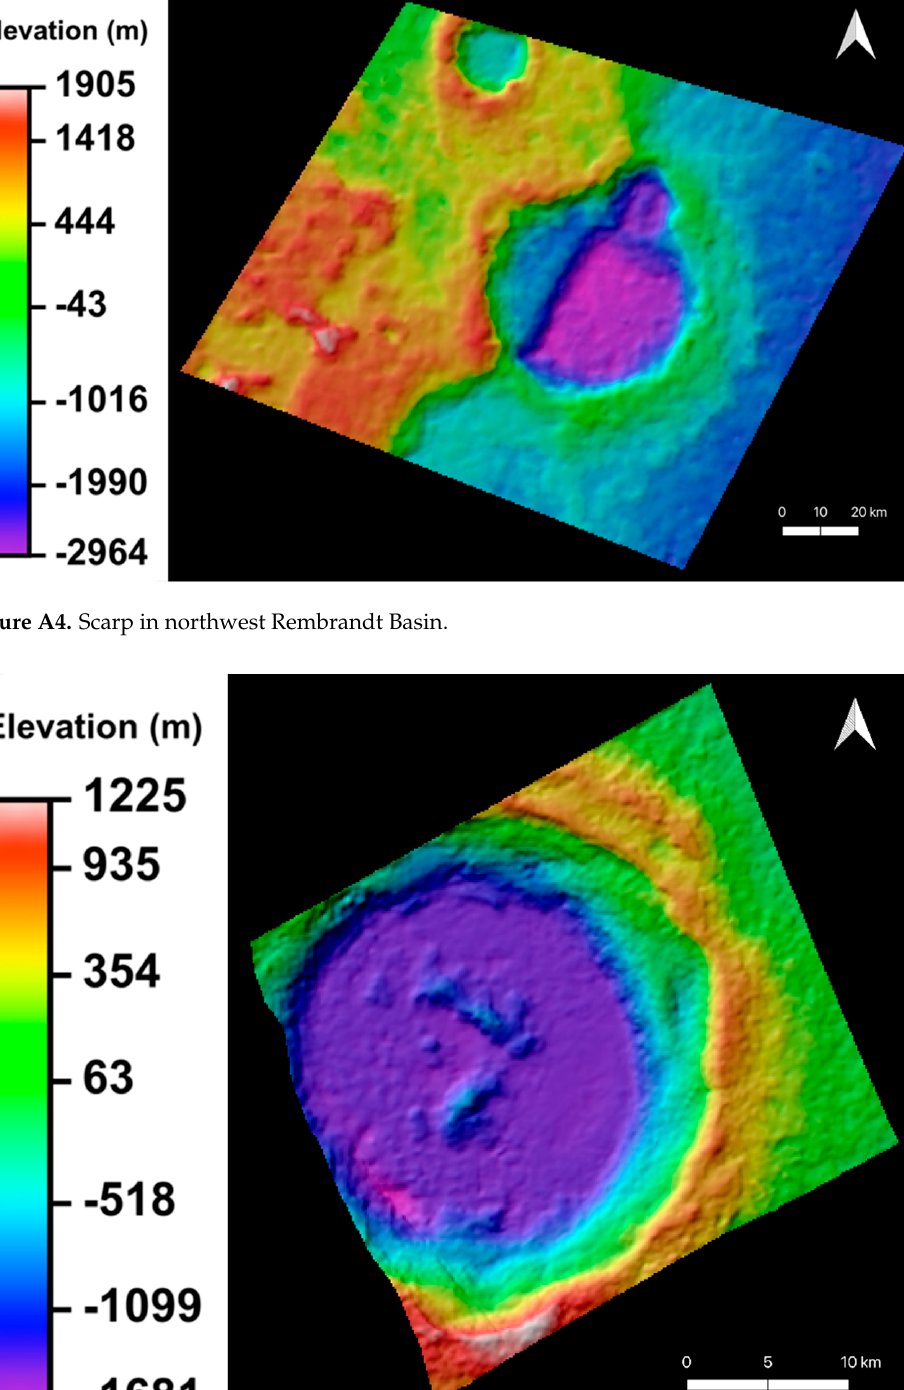
Figure A3. Degas Crater.